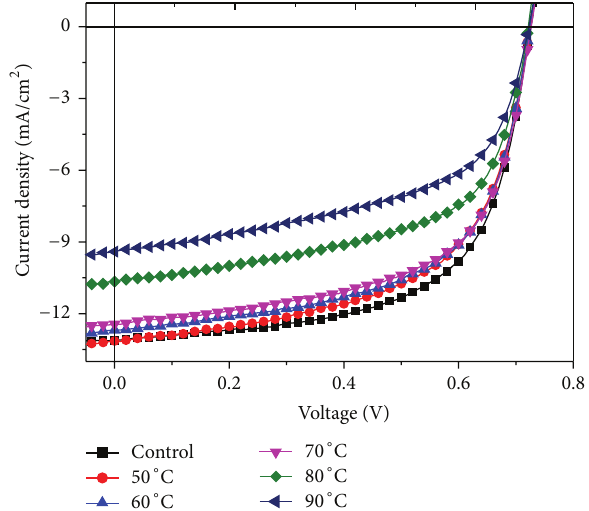
Figure 3: J-V curves of the inverted solar cells treated at different